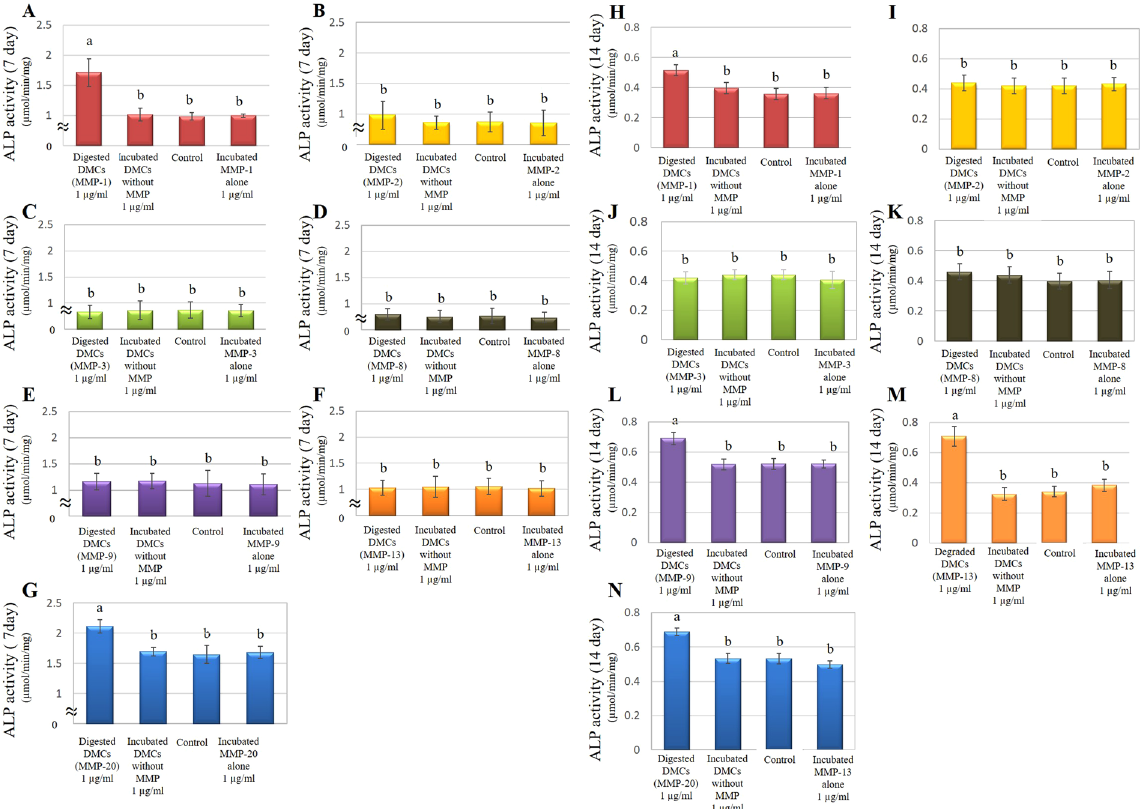
Figure 5. Effects of 1 µ g/ml of MMP-treated dentin matrix components (DMCs) on cell differentiation in rat primary pulp cells. Cells were treated with DMCs treated with matrix metalloproteinase (MMP)-1 ( A , H ), MMP-2 ( B , I ), MMP-3 ( C,J ), MMP-8 ( D,K ), MMP-9 ( D,L ), MMP-13 ( E,M ), and MMP-20 ( G,N ), incubated DMCs without MMP or medium alone containing 50 μ g/ml of ascorbic acid and 10 mM of β -glycerophosphate for 7 days ( A–G ) or 14 days ( H–N ). One microgram per millilitre of DMCs treated with MMP-1 ( A ) or MMP- 20 ( G ) showed higher alkaline phosphatase (ALP) activities, compared with incubated DMCs without MMPs at 7 days (p < 0.05). On day 14, DMCs treated with MMP-9 ( L ) and -13 ( M ) also stimulated pulp cell ALP activity in addition to MMP-1 and -20 (p < 0.05). Significant differences were not observed with 1 µ g/ml of DMCs treated with other MMPs, MMPs incubated alone, or at lower concentrations (0.01–0.1 µ g/ml) of the above-mentioned MMPs. Groups with similar lower-case letters (i.e., a and b) are not significantly different (Supplementary Figure 7). Data represent five independent